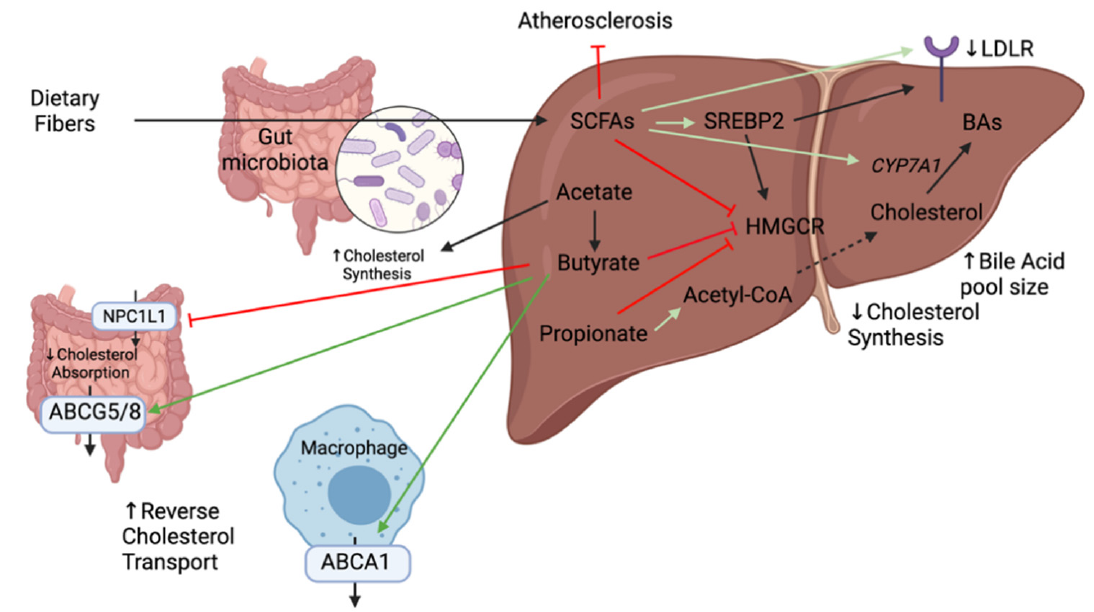
Figure 6. Mechanisms linking the anti-atherosclerotic activity of short-chain fatty acids (SCFAs) and cholesterol transport and synthesis in the intestine and liver. Dietary fibers could be fermented and transformed into short chain fatty acids (SCFA) by some species present in the gut. Green arrows indicate an increase of activity or expression whereas the red arrows indicate an inhibition or reduction of expression.